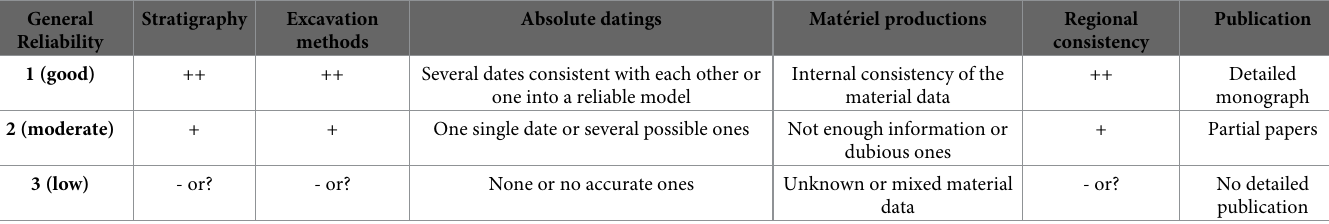
Table 2. Criteria for assessing the reliability of prehistoric